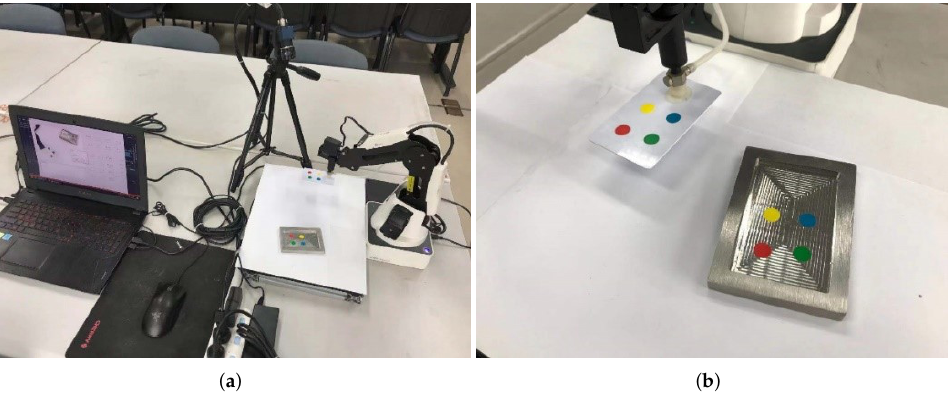
Figure 11. Experimental setup: ( a ) Complete experimental platform. ( b ) The white card and the